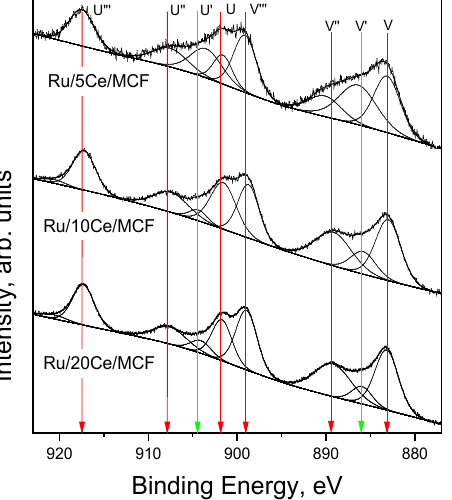
Figure 2. XPS spectra in Ce 3 d region.